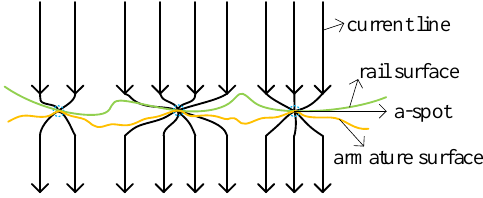
FIGURE 5. Schematic diagram of pivot rail contact